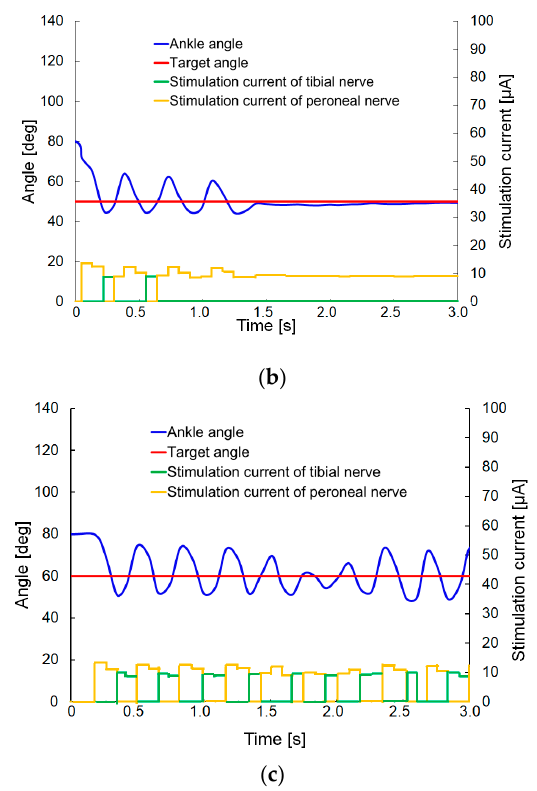
Figure 11. Experimental results for the step response: Results are shown for the following target angles for the rat ankle joint: ( a ) 40°; ( b ) 50°; ( c ) 60°.